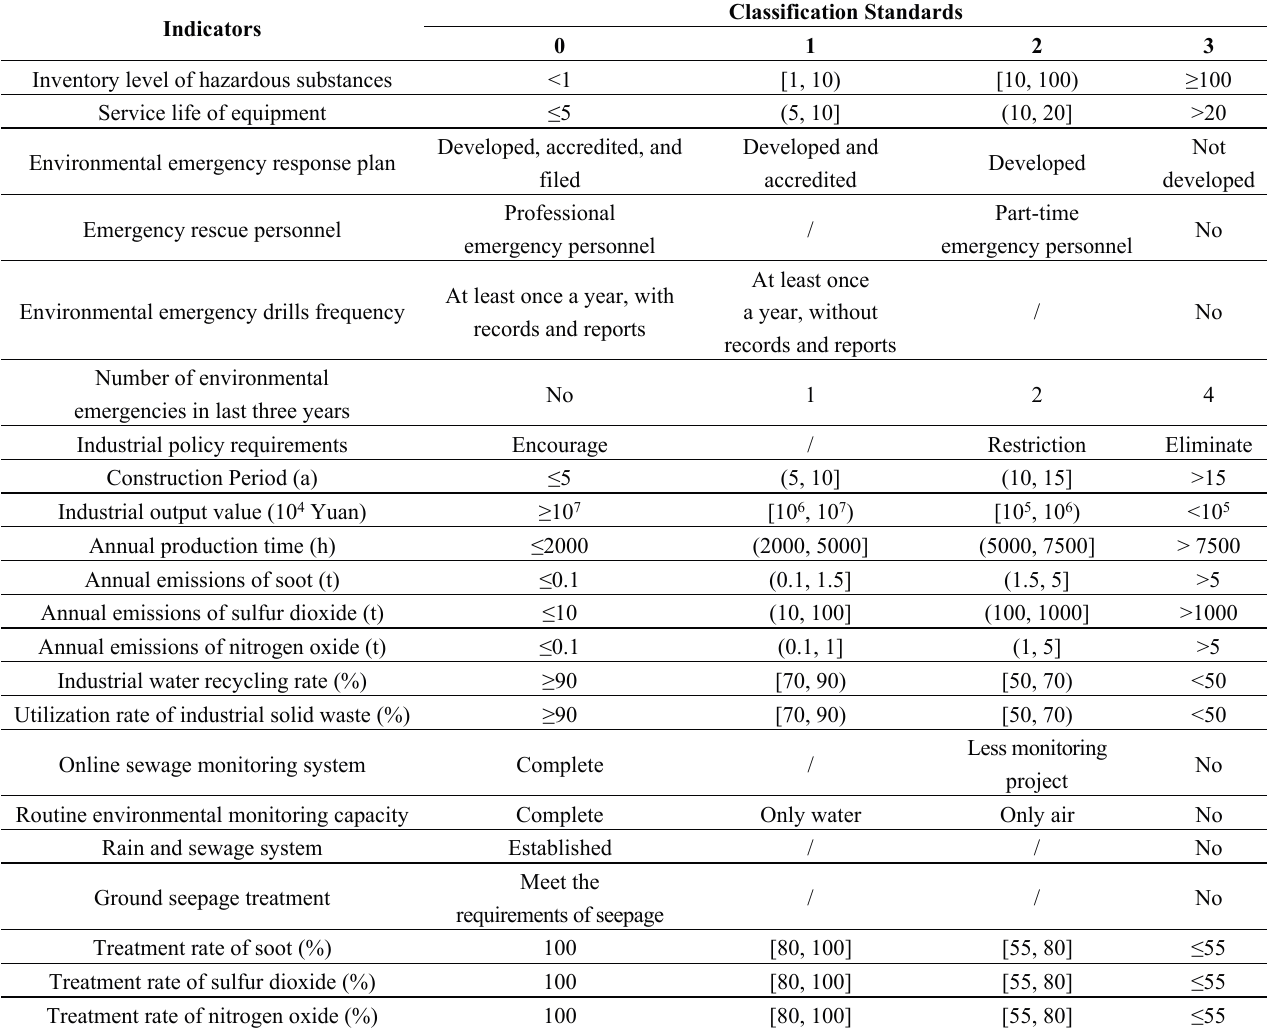
Table A4. Grading standards of the assessment